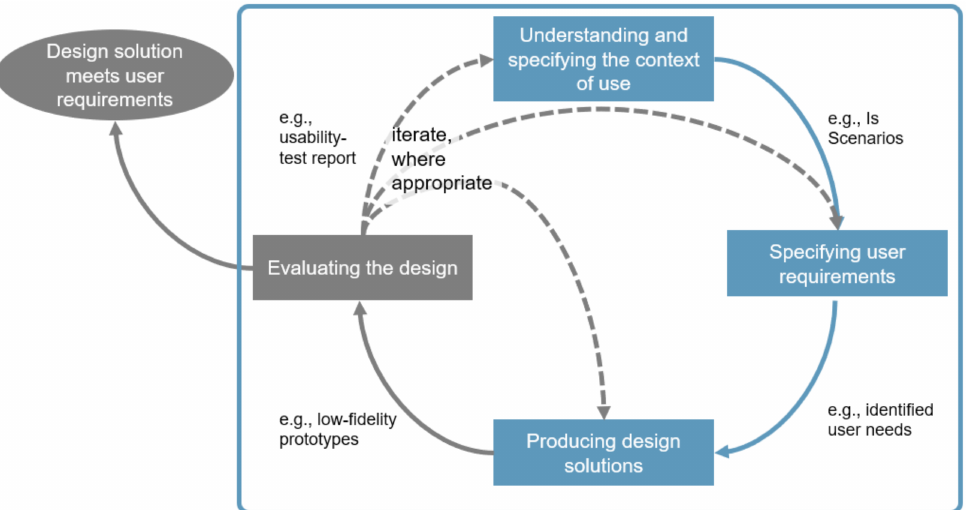
Figure 3. The user-centered design process is adapted from ISO [23]. Scenarios are a central element of understanding and specifying the context of use and determine user requirements that in turn help produce design solutions. Adapted from Ref. [22], 2019, ISO.